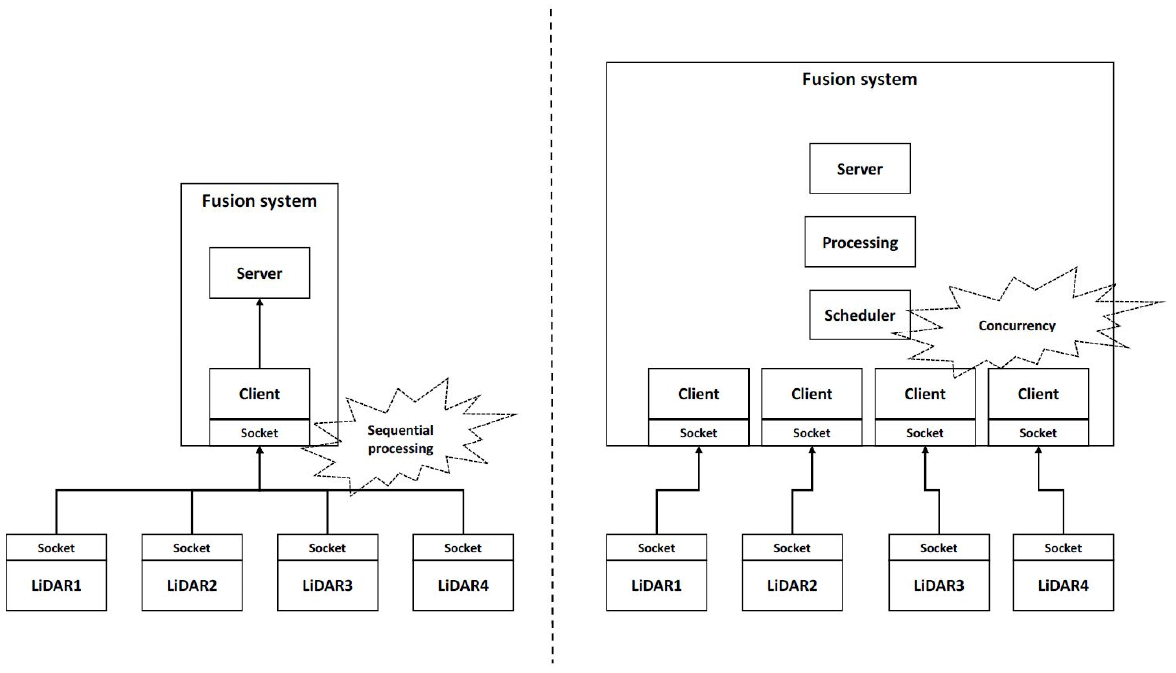
Figure 2. Sequential processing vs. multiprocessing.